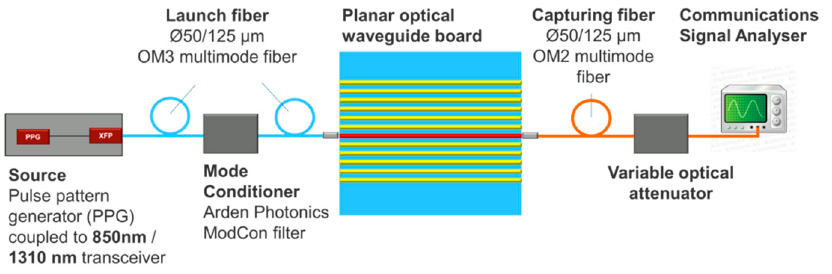
Figure 15. Signal integrity measurement set-up.